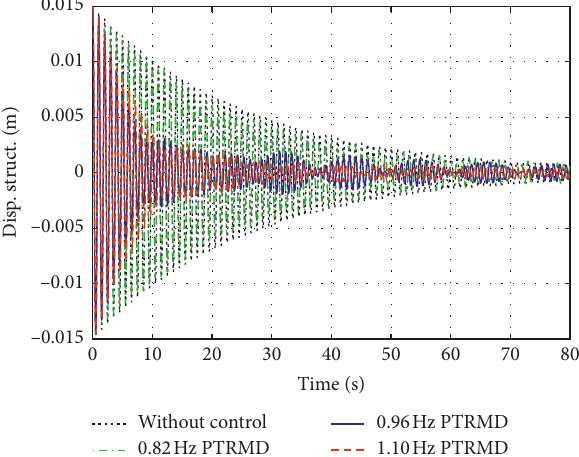
Figure 18: Response of the structure controlled by PTRMD with different frequencies for free vibration.